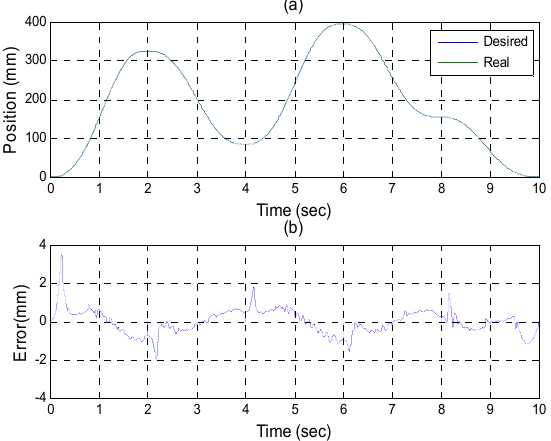
Figure 23. Experiments for C axis cylinder ( a ) tracking responses ( b ) tracking errors.